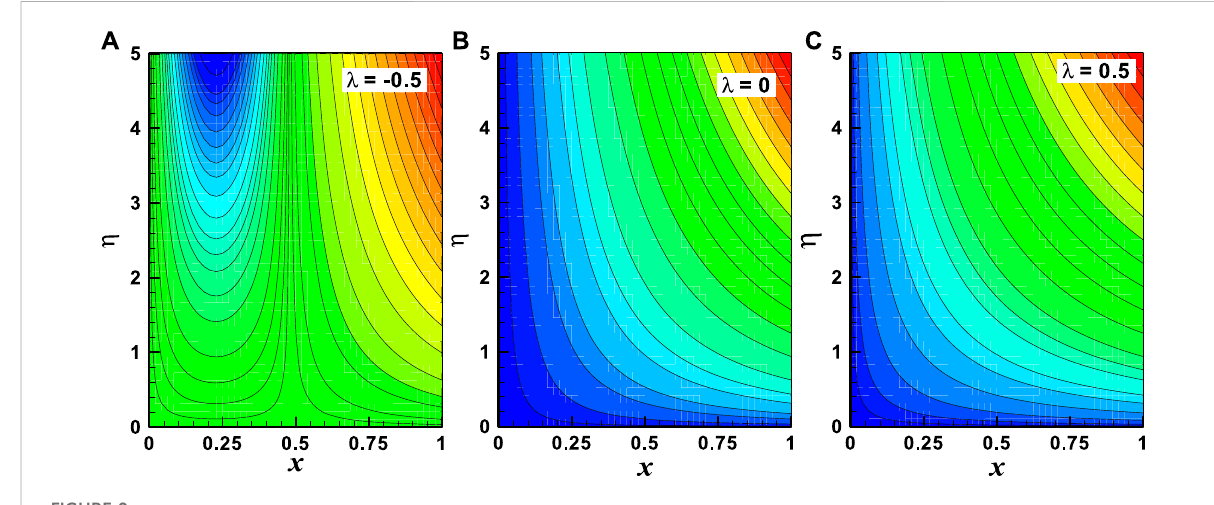
FIGURE 9 (A – C) Streamlines with the variation of the moving wedge parameter ( λ ). Other parameters are m = 1, M = 2, and α = 0.3.